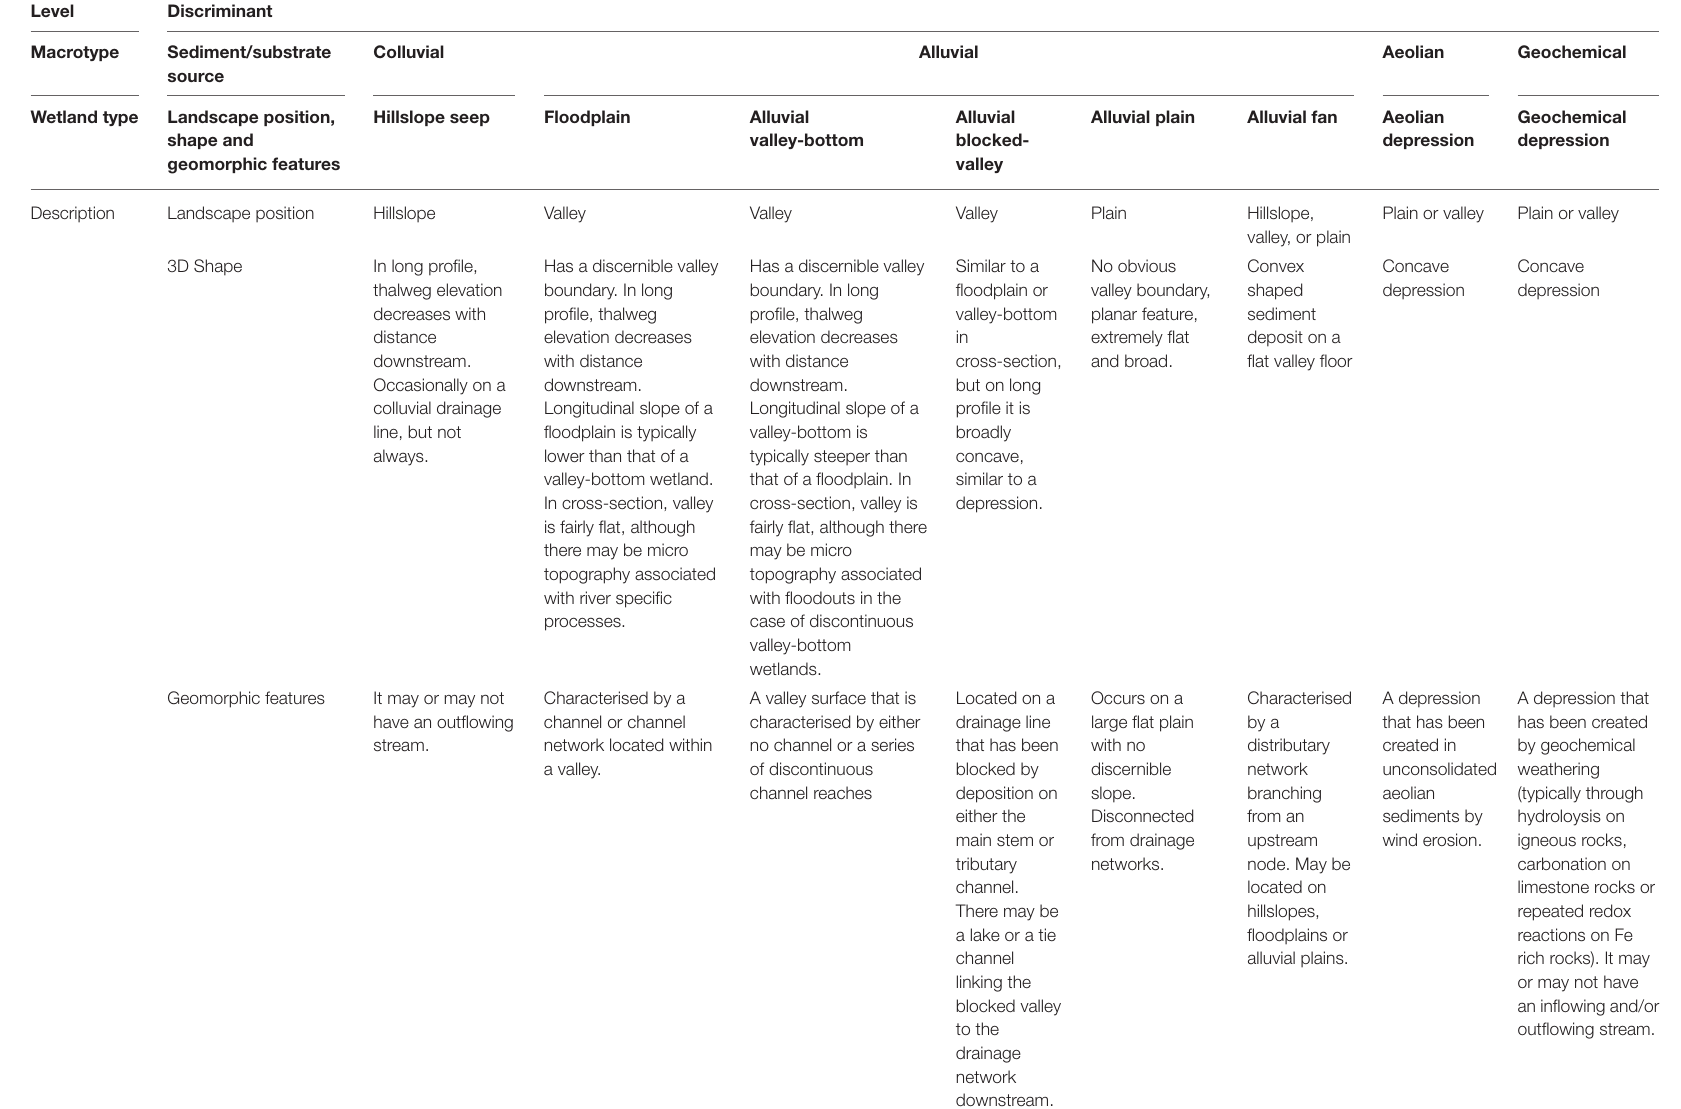
TABLE 1 | Macrotypes and types of a genetic geomorphic classification of inland wetlands for dryland regions, sub-types are provided on subsequent tables where